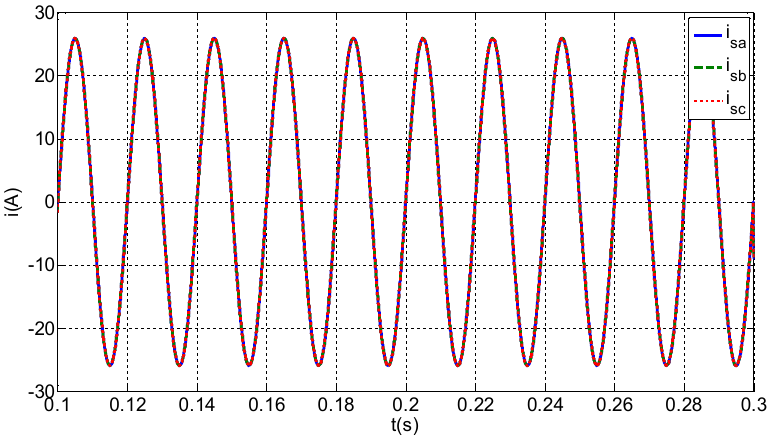
Figure 21. Zero-sequence current tracking waveform.